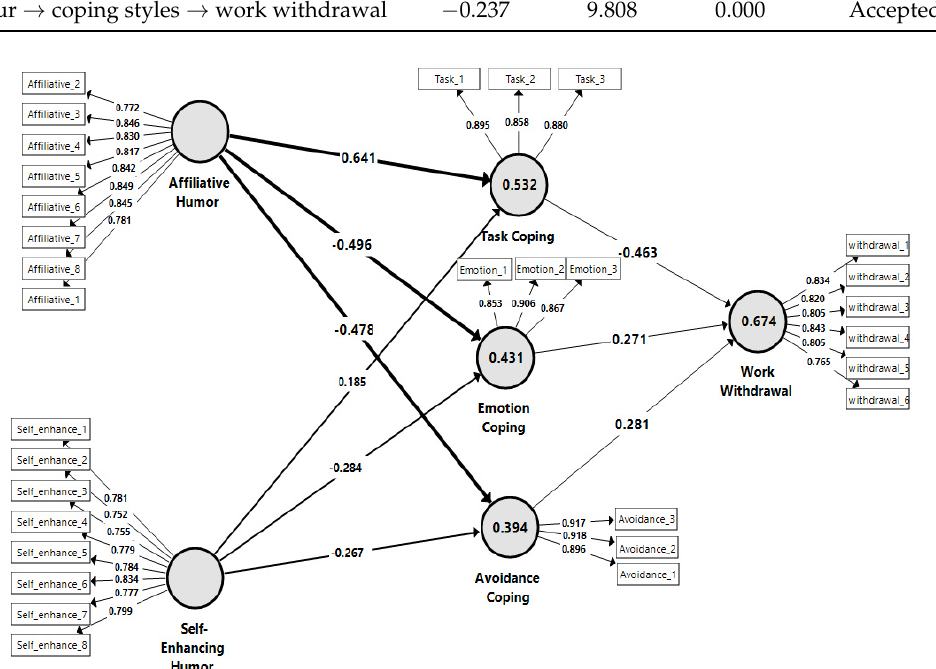
Figure 2. The tested structural and measurement